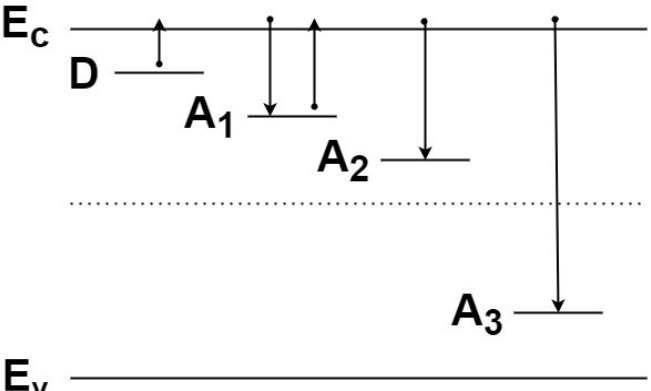
Figure 1. Schematic presentation of the main types of levels in the band gap of SiC. The arrows show the dominant electron transitions corresponding to the level. The dotted line corresponds to the middle of the band gap. Here, D is the shallow donor level; a relatively shallow acceptor level A1 associates with the Z 1/2 level; an A2 level associates with the E 6/7 level; and the A3 level represents the group of levels lying in the lower half of the band gap.